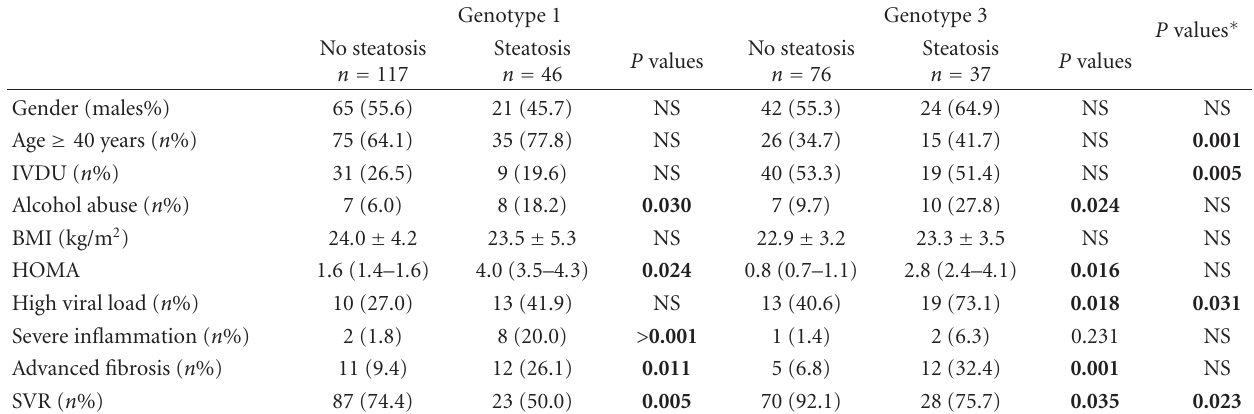
Table 5: Di ff erences of genotypes 1 and 3 in determinants of hepatic